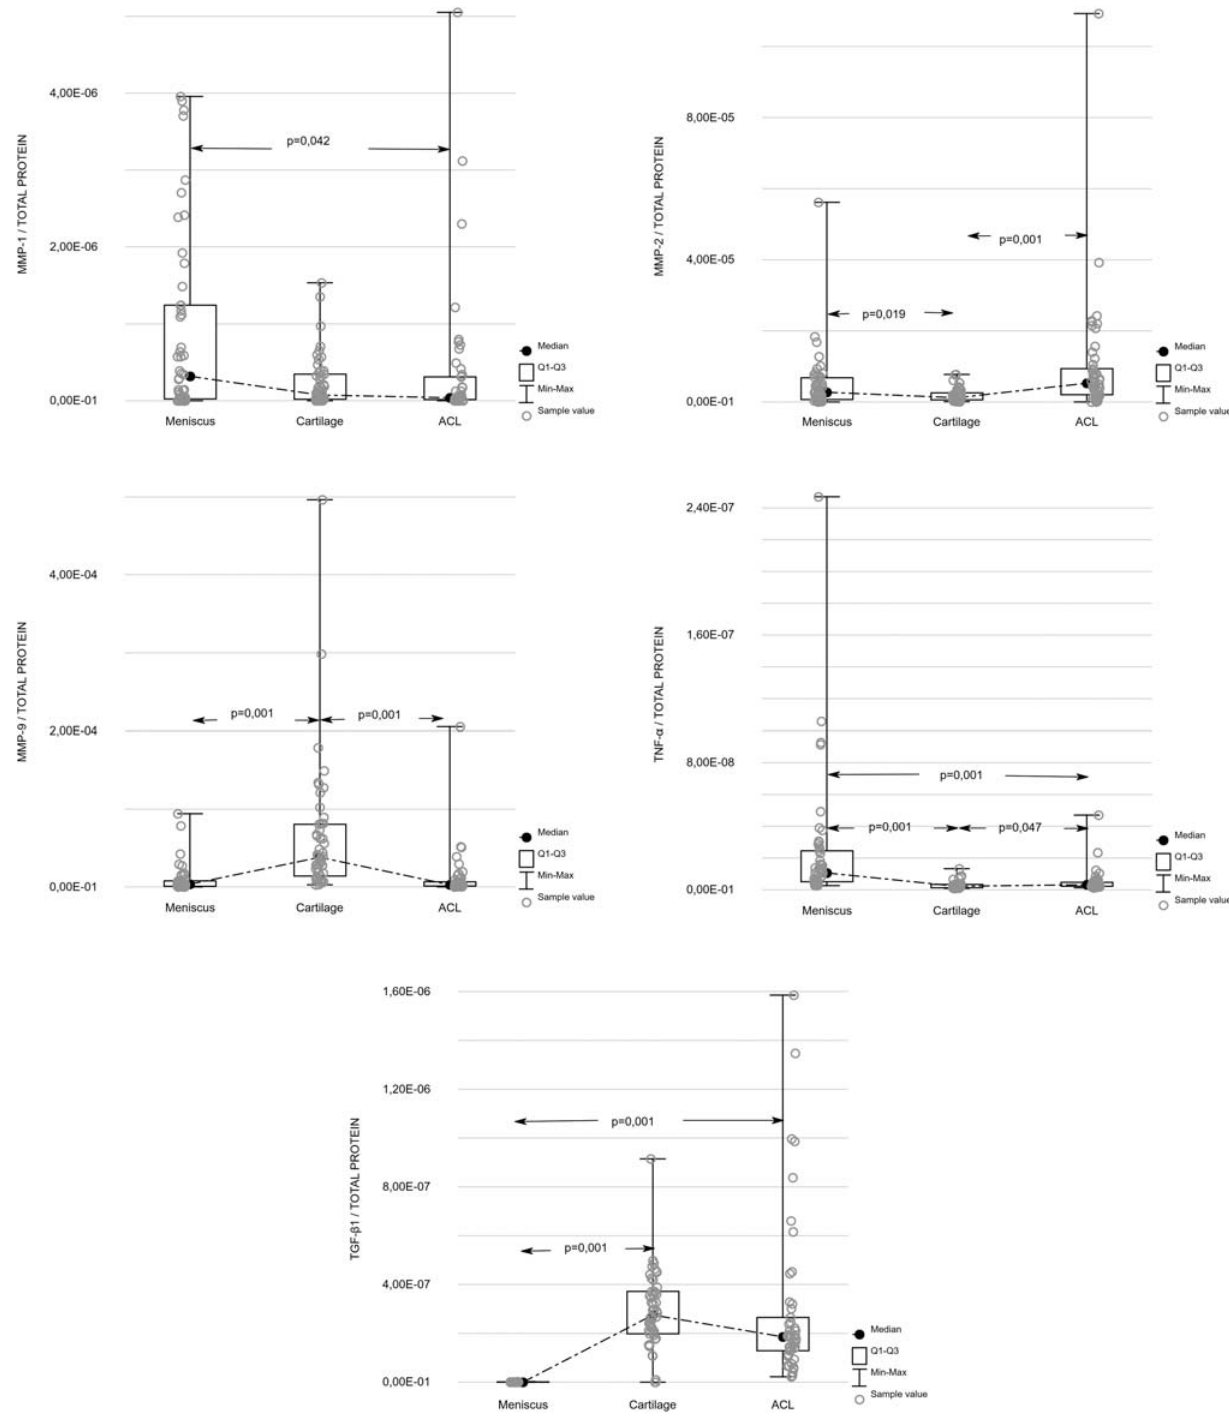
Figure 1: Concentration of investigated proteins ( pg/ml ) corrected with respect to overall protein concentration in anatomical structures ( pg/ml )